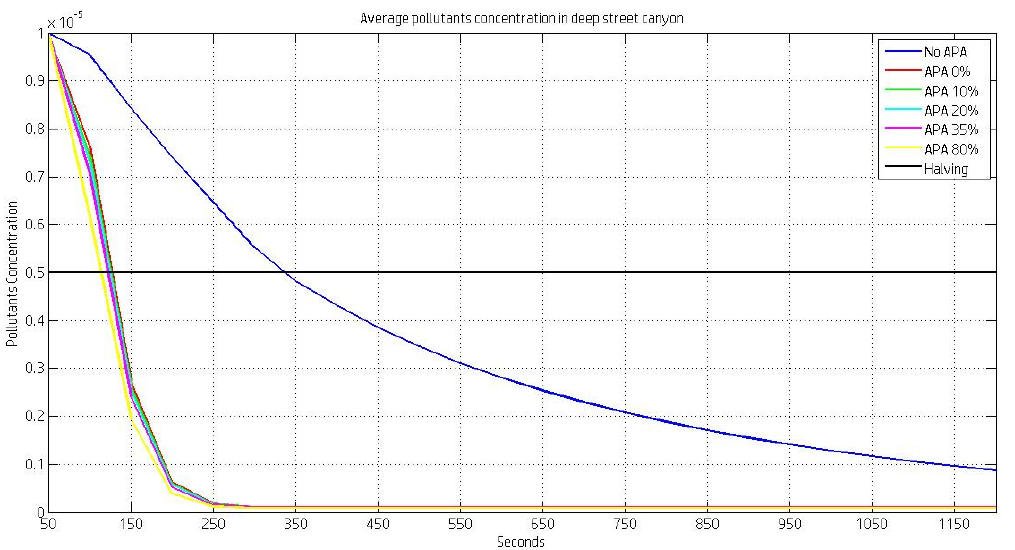
Figure 15. Time series of the average concentration of the passive tracer in a deep street canyon with aspect ratio H/W = 2 without (blue line) and with (color lines) the APA absorber. Different APA abatement efficiencies are analyzed. The black line denotes half of the initial concentration value used to calculate the canyon cleansing time.